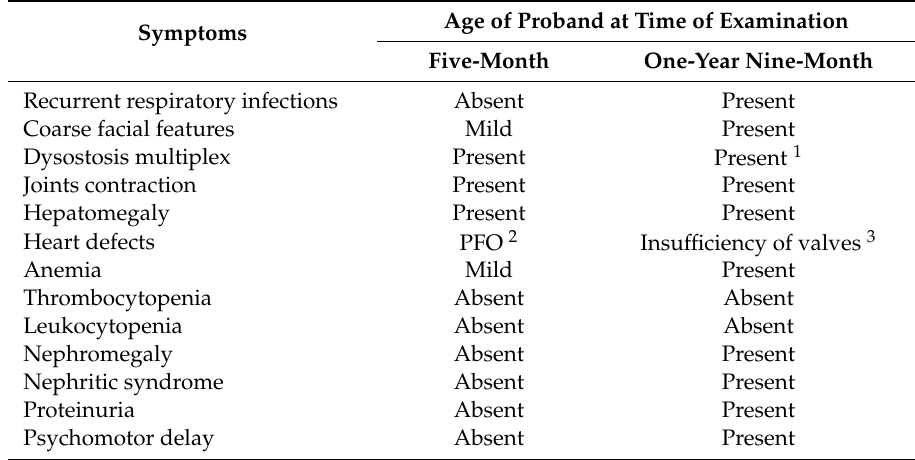
Table 1. Clinical characteristics of the proband.